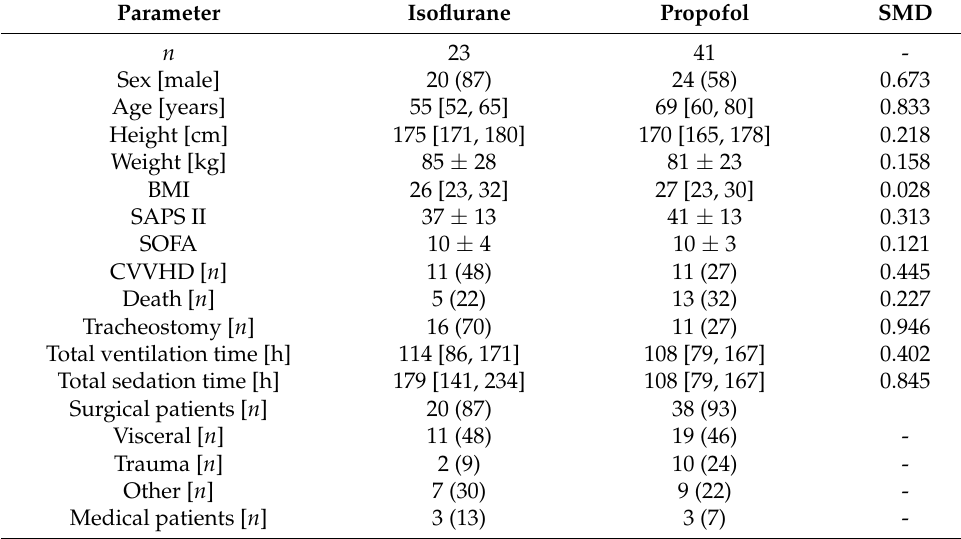
Table 1. Study population characteristics.